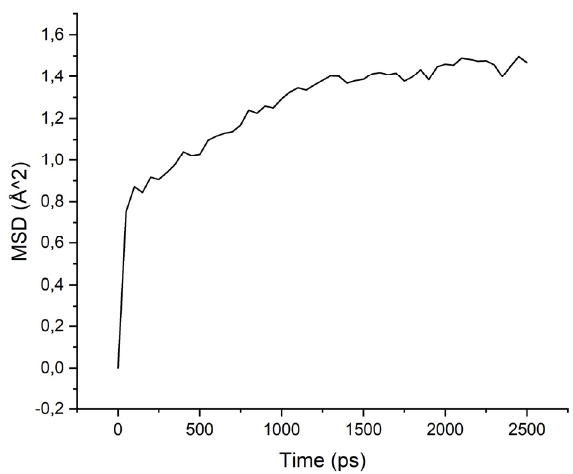
Figure 7. MSD for PBOI-isopropanol system.